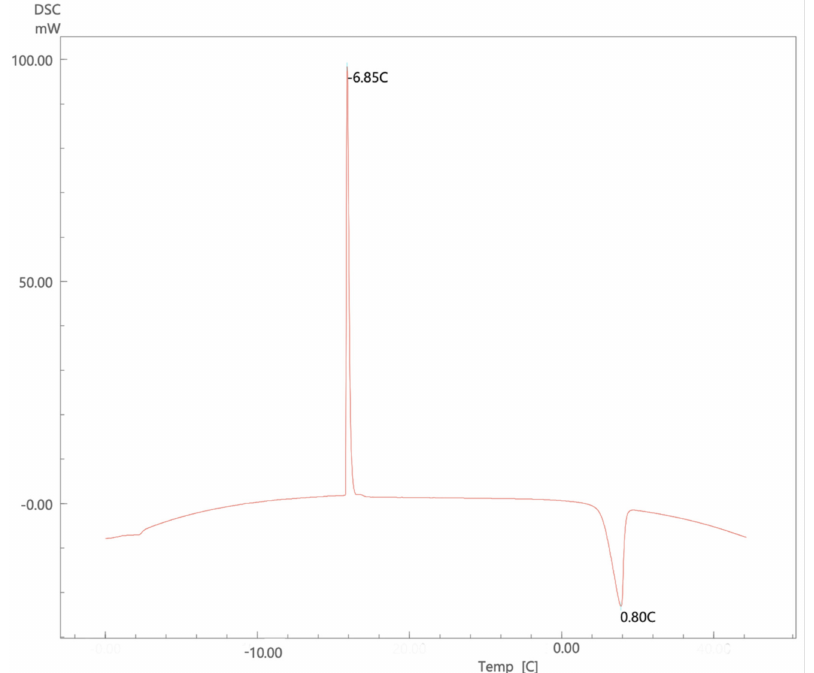
Figure 3. DSC thermogram of a representative lidocaine nanoemulsion using coconut oil at surfactant- to-oil ratio